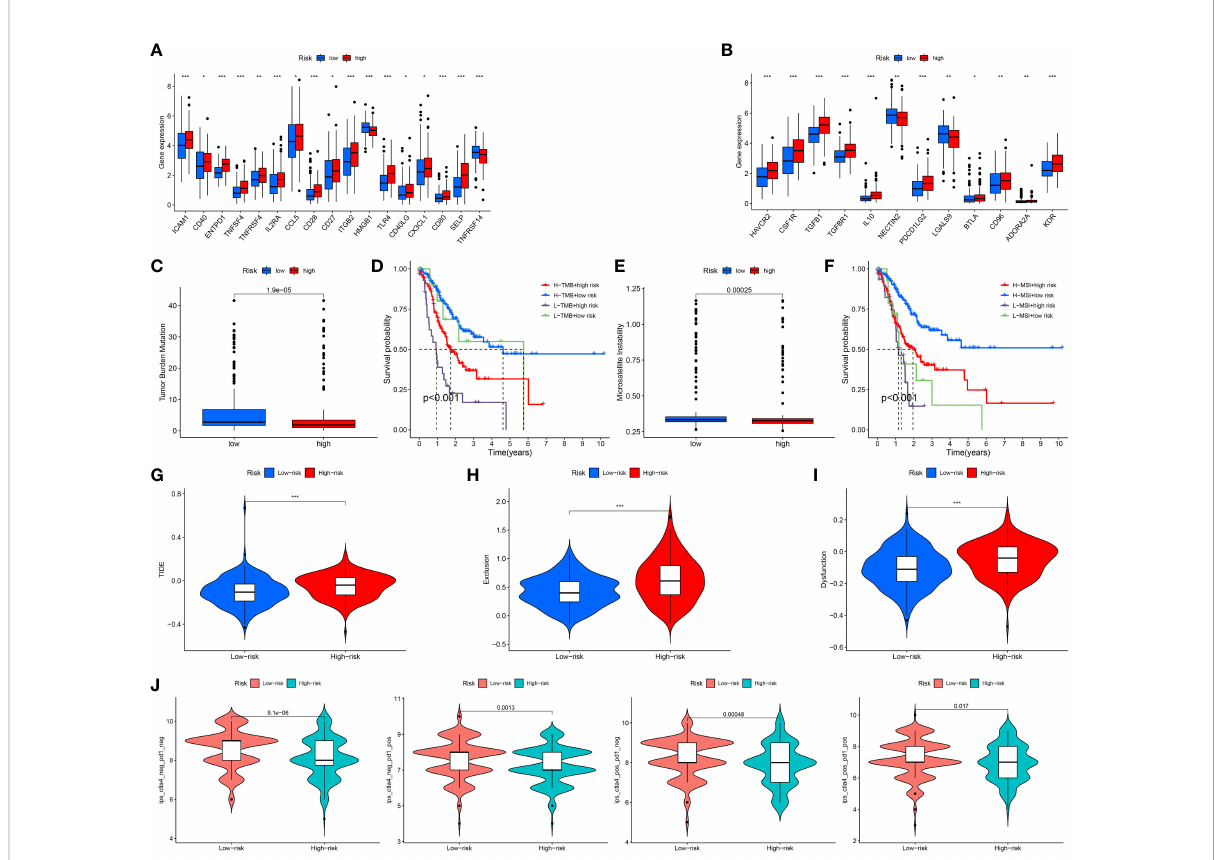
FIGURE 7 Assessment of Immunotherapy response of high and low risk groups. (A, B) The ICP gene expression levels in different groups. (C) The TMB scores in different groups. (D) Survival differences among patients with different TMB scores combined with different risk scores. (E) The MSI scores in different groups. (F) Survival differences among patients with different MSI scores combined with different risk scores. (G – I) The TIDE scores in different groups. (J) The IPS scores in different groups. *P < 0.05; **P < 0.01; ***P <